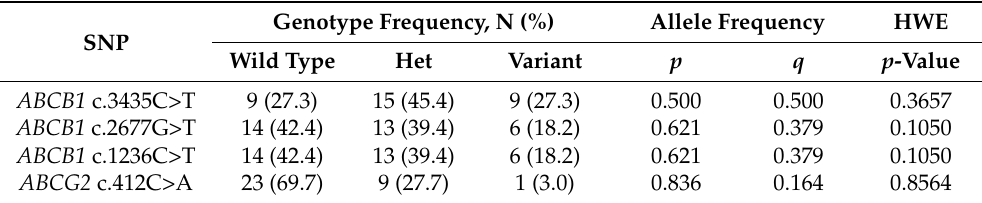
Table 2. Genotype and allele frequency distribution for ABCB1 c.3435C>T, c.2677G>T, c.1236C>T,